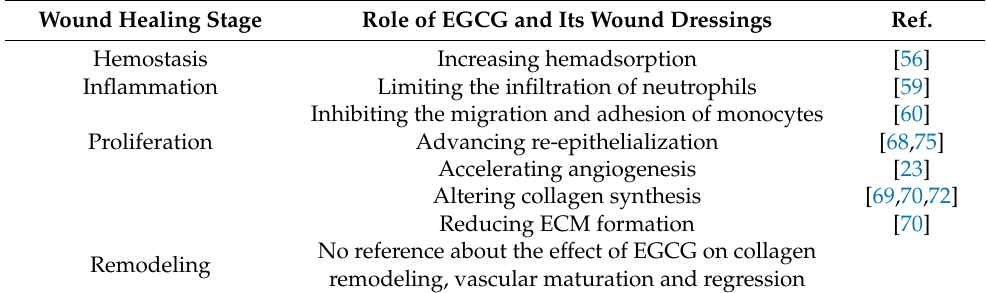
Table 1. The roles of EGCG and its wound dressings in the biophysiological events at different wound healing